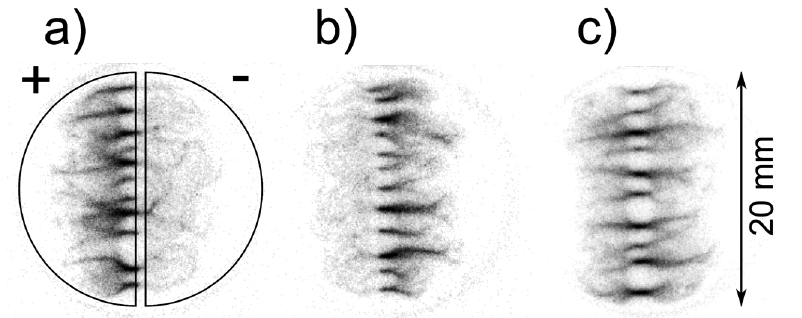
Figure 3 : Time resolved iCCD images of DCSBD generated in air using sine-wave HV; a) positive half-period of the discharge, b) negative half-period of the discharge and c) whole period of discharge. The position of electrodes and their instantaneous polarities are given for the positive half-period; polarity is switched for the negative half-period.